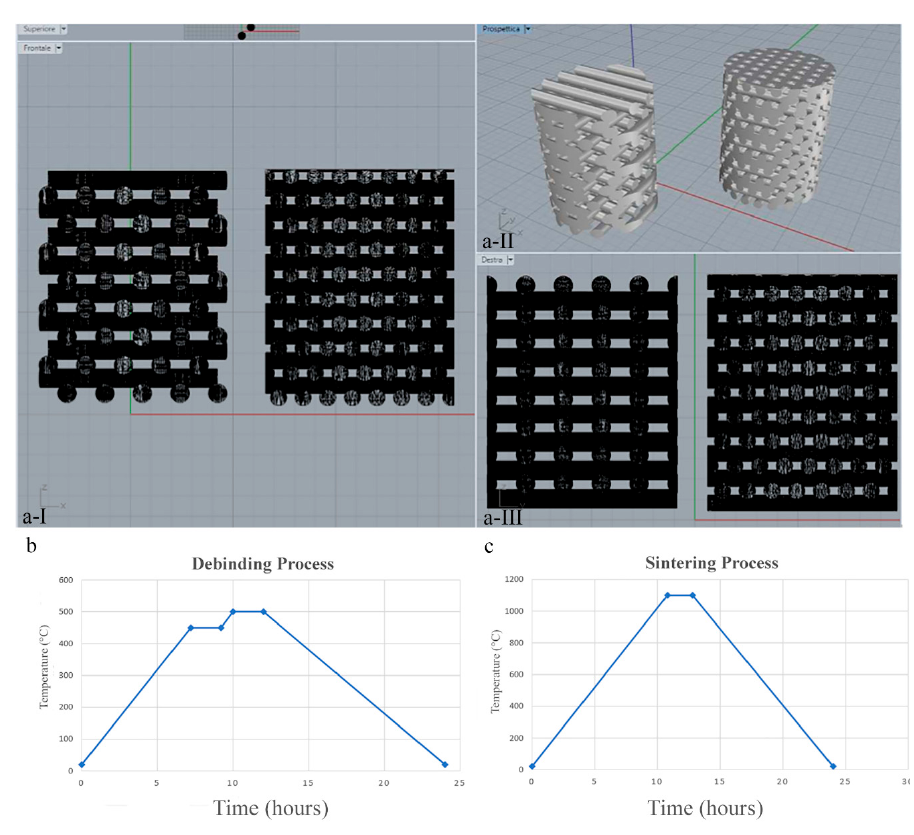
Figure 7. Three-dimensional printed samples design and production: ( a-I ) Printed@BigPores samples, with parallel links translated in the x -axis; ( a-II) CAD reconstruction of the 3D-printed samples produced by laser light stereo-lithography (SLA); ( a-III ) Printed@SmallPores samples, with parallel links translated both in x - and in y -axes; ( b ) temperature vs. time graph of the debinding process; ( c ) temperature vs. time graph of the sintering